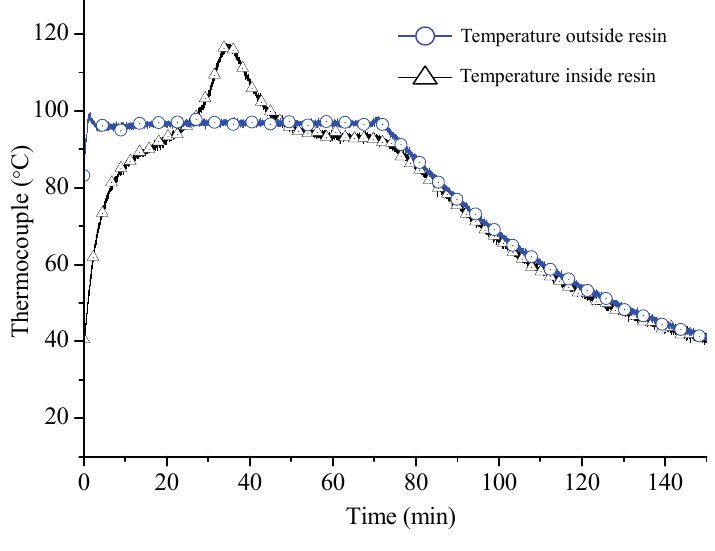
Figure 7. Temperature profiles measured in oven and epoxy resin.